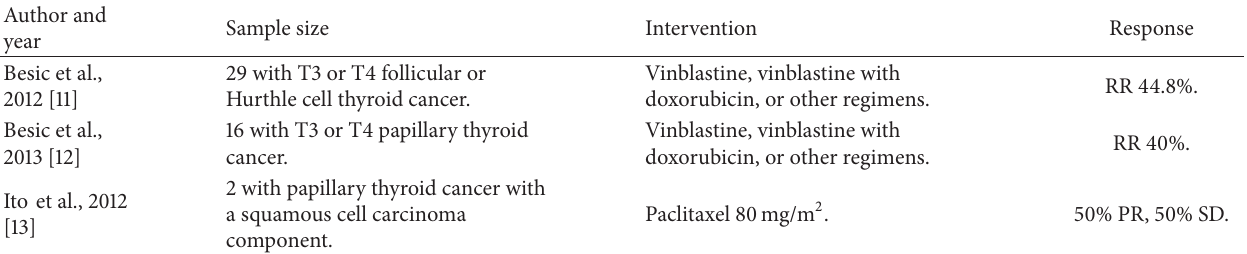
Table 2: Responses to neoadjuvant chemotherapy in differentiated thyroid cancer.